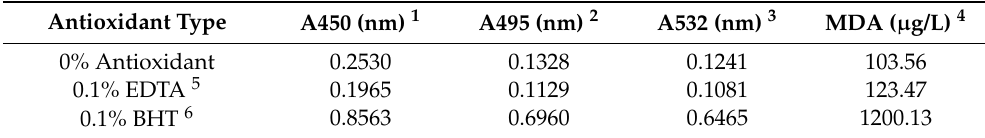
Table 2. The absorbances obtained in all three selected situations ( n = 3). Antioxidant